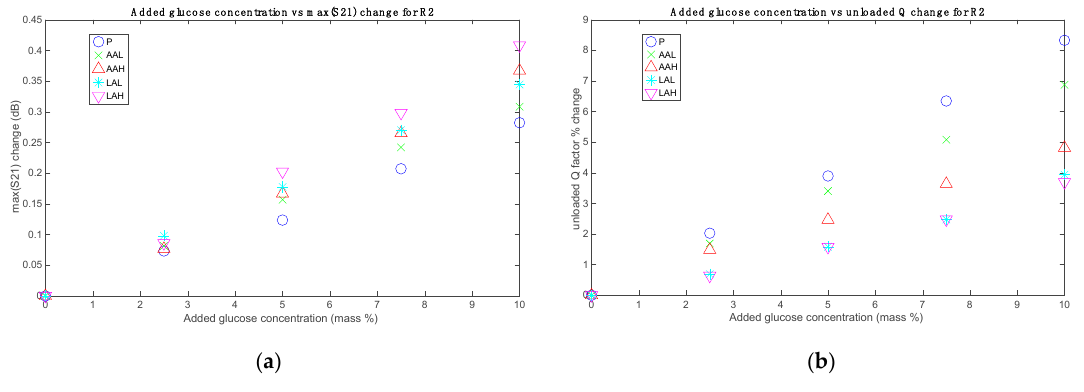
Figure 4. ( a ) Measurements with R1: absolute changes for S21 max ; ( b ) Measurements with R1: percentage changes for the resonator unloaded quality factor Q u .